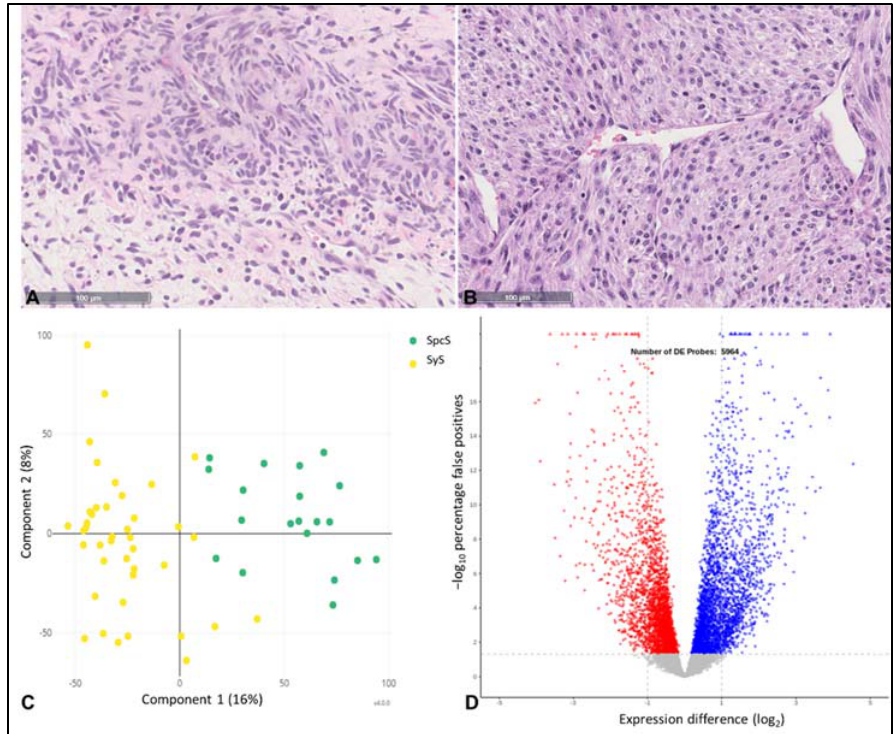
Figure 3. Differences between SyS and SpcS. ( A ) H&E staining of SyS. ( B ) H&E staining of SpcS. ( C ) This PCA plot depicts two distinct groups of expression pattern of genes within the two entities. ( D ) Volcano plot of tested genes. A total of 5964 genes showed differential expression when comparing synovial sarcoma vs. spindle cell sarcoma samples. Blue dots indicate elevated expression in synovial sarcomas and red dots depict elevated expression in spindle cell sarcomas. The y -axis indicates the log10 of the rank products percentage of false positives value as a function of the mean expression difference for the tested genes (adjusted p -value) and the x -axis indicates the log2 fold-change of gene